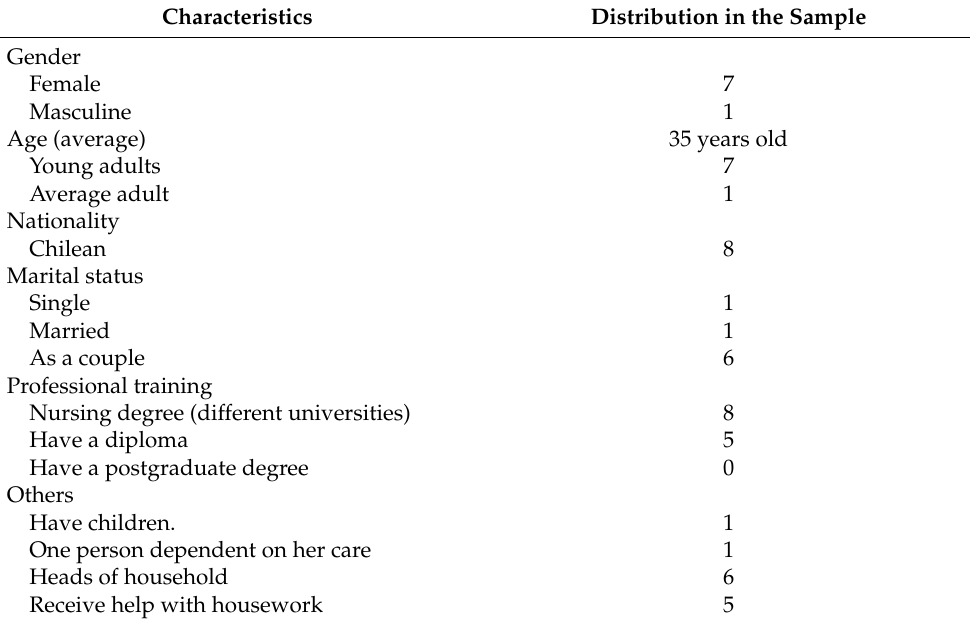
Table 1. Sociodemographic characterization ( n = 8) Santiago, Chile